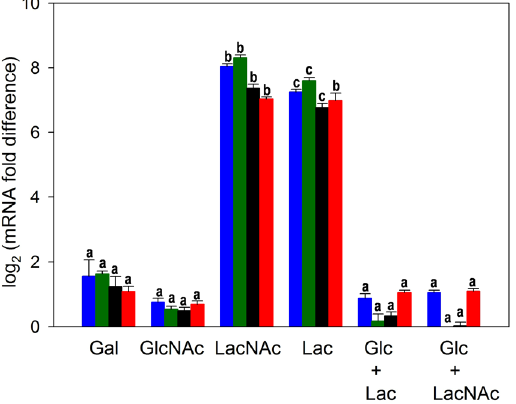
Figure 6. Transcriptional analysis by RT-qPCR of the expression of lacT (blue bars), lacE (green bars), lacG (black bars) and lacF (red bars) in Lactobacillus casei wild type strain BL23 grown in sugar-free MRS containing galactose (Gal), N -acetylglucosamine (GlcNAc), N -acetyllactosamine (LacNAc), lactose (Lac), a mix of glucose and lactose (Glc + Lac) or a mix of glucose and N -acetyllactosamine (Glc + LacNAc). Cells grown in sugar-free MRS supplemented with glucose were used as reference condition. Data presented are mean values based on three replicates of at least two biological independent samples. Bars indicate standard errors. For each lac gene, significantly different values ( P < 0.05) among culture conditions are marked by different lower-case